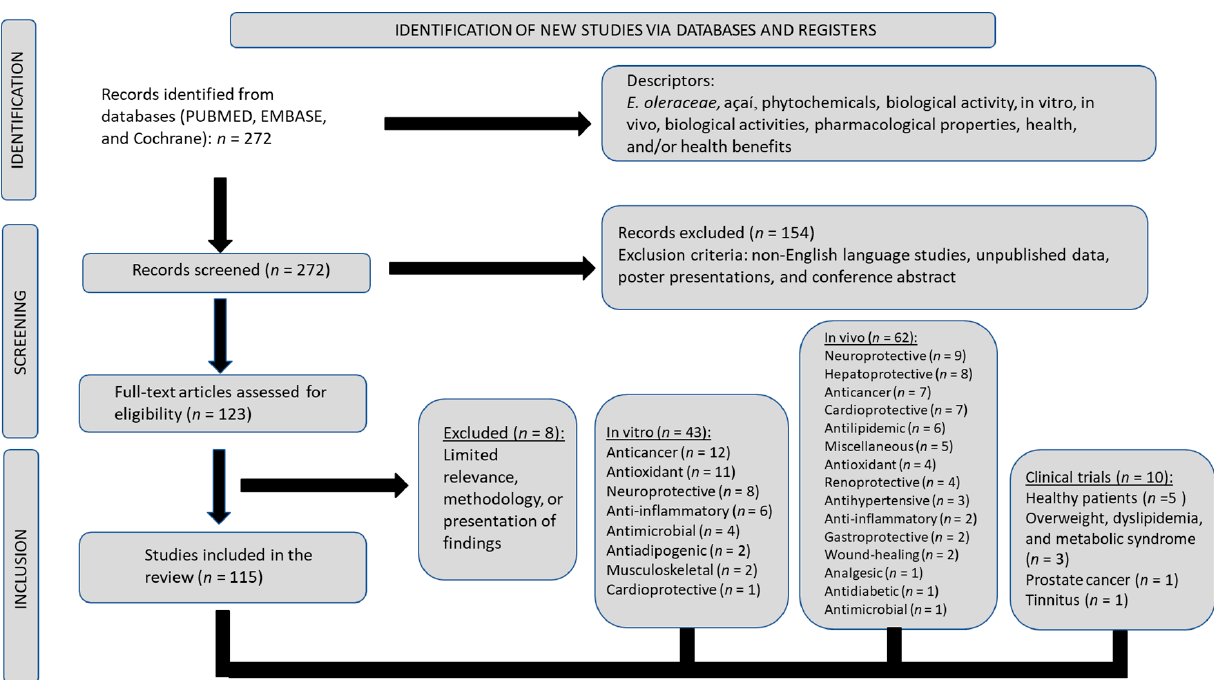
Figure 7. Flow diagram showing the study selection.